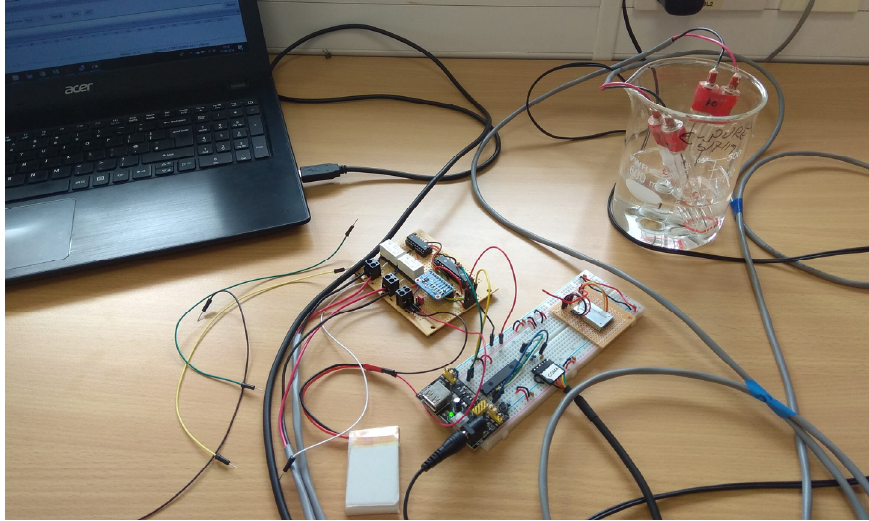
Figure 6. Prototype IoT soil sensor node undergoing laboratory tests.